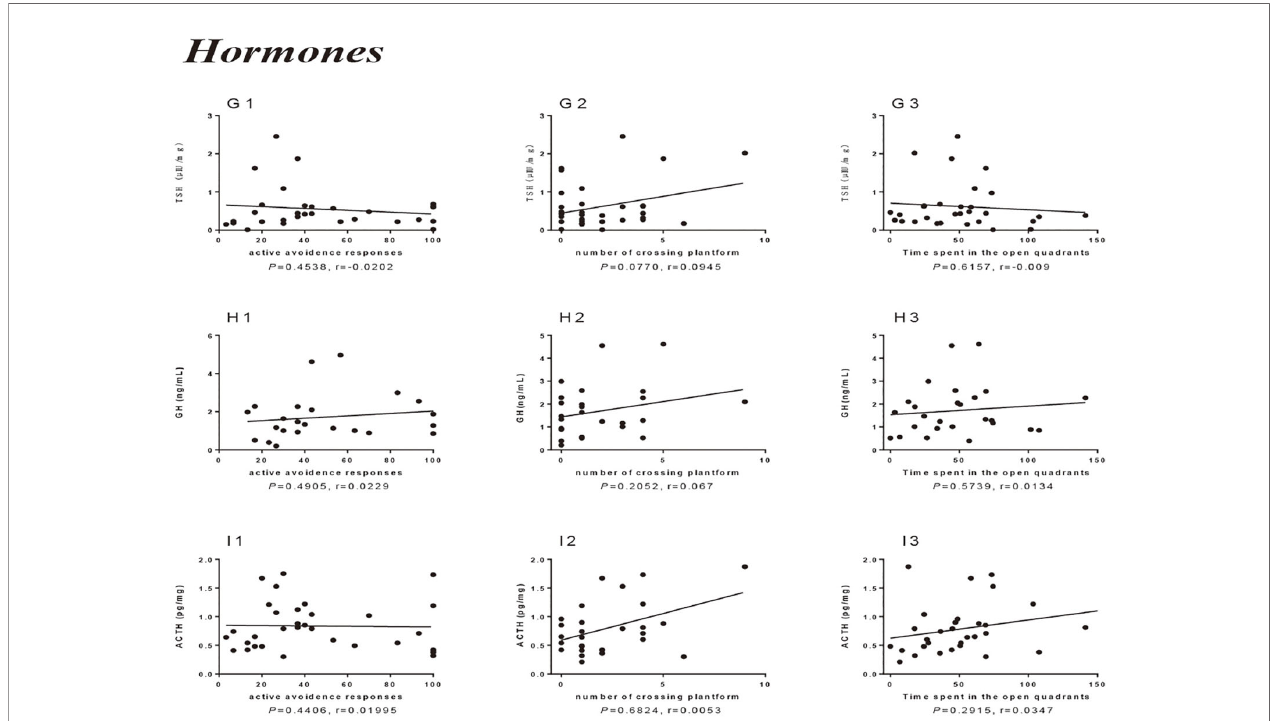
FIGURE 7 | Correlation analysis between neuroendocrine-immune factors and behavior tests in old SAMR1 mice. The pro-in fl ammatory factors (A1-3) TNF a , (B1-3) IL-1 b , (C1-3) IL-6, and (D1-3) G-CSF as well as the anti-in fl ammatory factors (E1-3) IL-5 and (F1-3) IL-10, hormones (G1-3) TSH, (H1-3) GH and (I1-3) ACTH related with active avoidance response, spatial memory and anxiety behavior of old SAMR1 mice. Pearson correlation analysis, n = 24-33, P < 0.05 was considered to be a signi fi cant